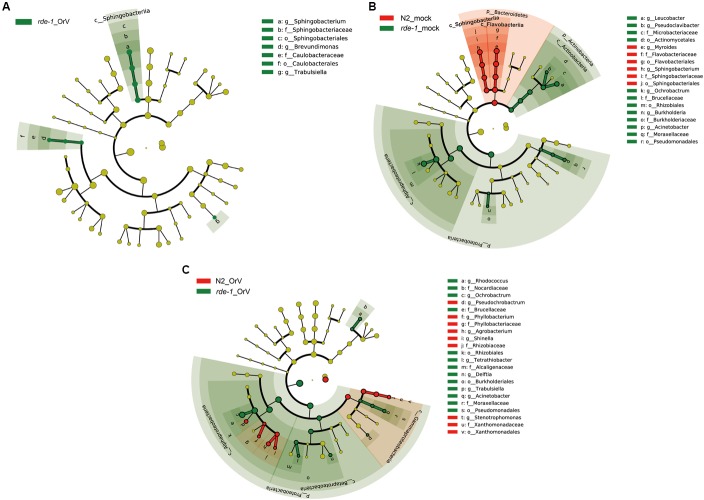
rde-1 (ne219) mutant and N2 animals harbor distinct bacterial communities. (A) LEfSe analysis of microbiomes between uninfected and Orsay virus-infected group in rde-1 (ne219) mutants. The taxa that were found at a significantly higher relative abundance in Orsay virus-infected group (green) relative to the uninfected samples are highlighted. (B) LEfSe analysis of microbiomes between uninfected N2 and rde-1 (ne219) mutants. (C) LEfSe analysis of microbiomes between Orsay virus-infected N2 and rde-1 (ne219) mutants. The taxa that were found at a significantly higher relative abundance in N2 (red) and rde-1 (ne219) (green) are highlighted. For the cladogram, yellow circles represent non-significant microbial clades.